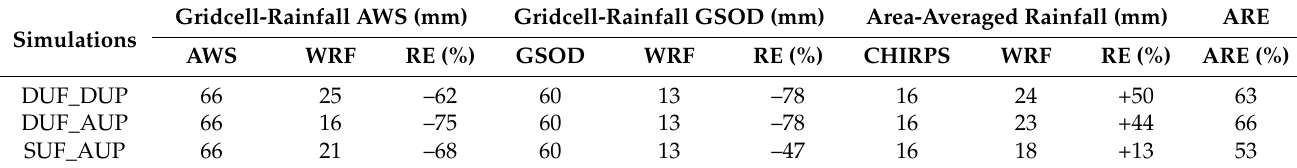
Table 3. Comparison of WRF rainfall with the stations (AWS and GSOD) and Area-averaged regrid- ded CHIRPS rainfall for DUF_DUP, DUF_AUP, and SUF_AUP simulations for 25 June 2012 rainfall events in Kampala, Uganda. The areal rainfall amount is the average of all grids in the innermost domain of